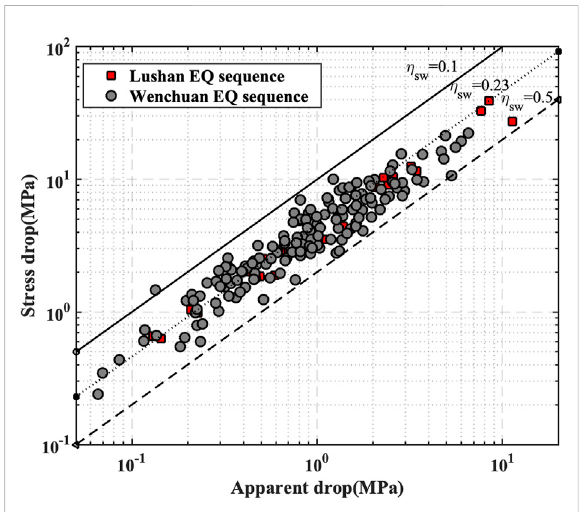
FIGURE 7 Apparentstresscomparedtostressdrop,showingtheoretical relation in black